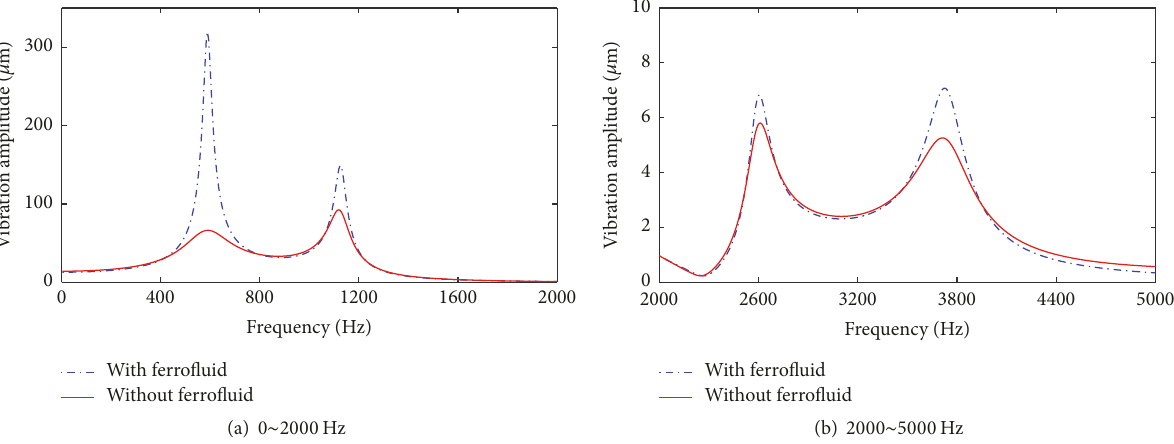
Figure 12: Harmonic responses of end part of feedback rod.